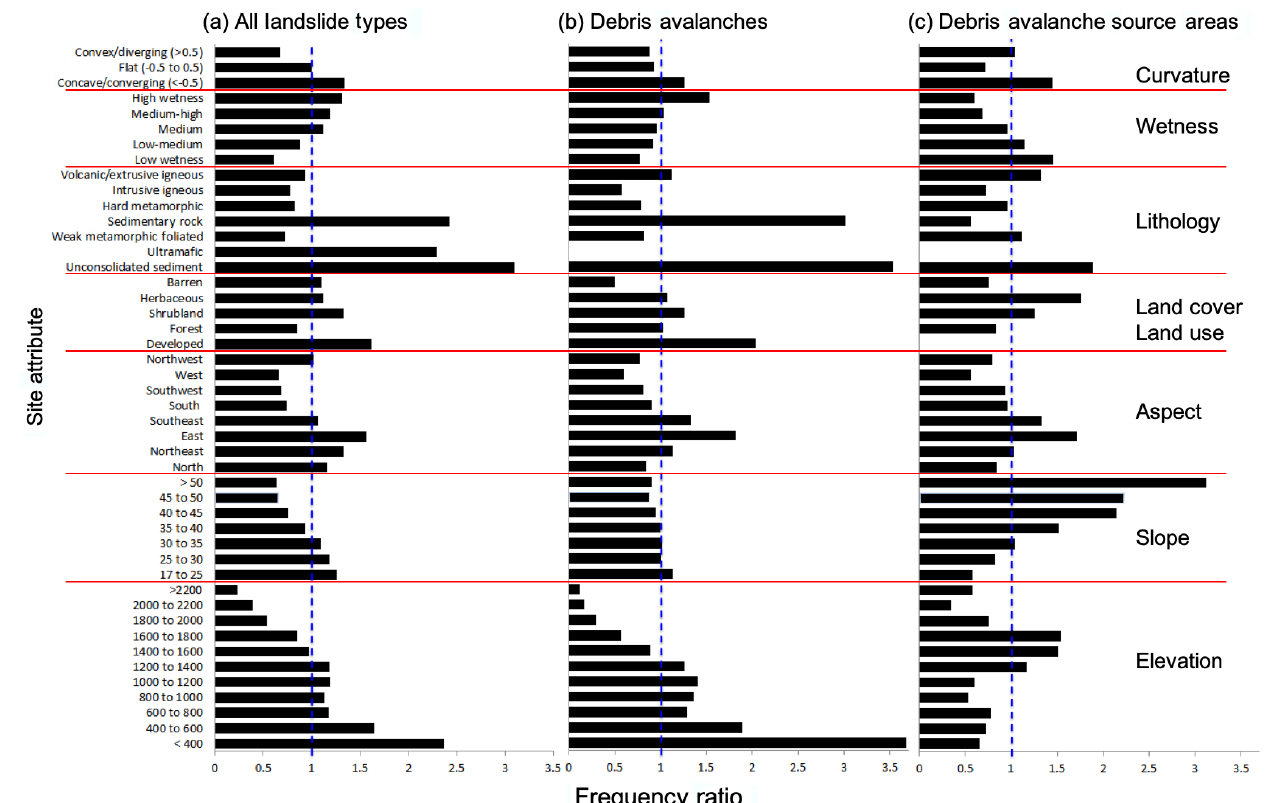
Figure 4. Frequency ratio (FR) values for different bins of seven site attributes (SA) separated by red lines, based on (a) all landslide types mapped within the NOCA study domain, (b) debris avalanche landslide types only, and (c) source areas of debris avalanches represented by the highest 20% of the mapped debris avalanche. The vertical blue line refers to the FR value of 1.0, denoting when no association is found with mapped landslides. FR values below this line are attributes less likely associated with landslides, and FR values above this line indicate a greater association with